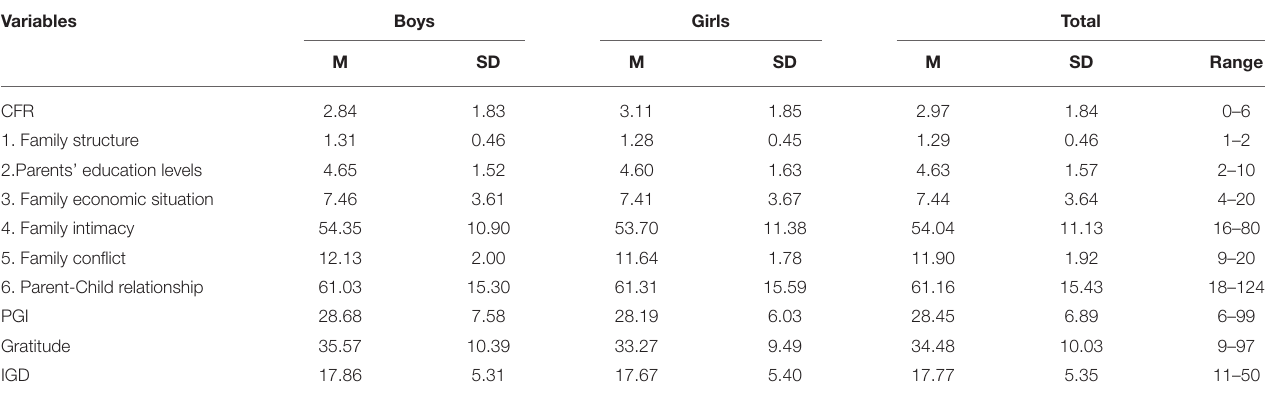
TABLE 1 | Descriptive statistics of key variables. Variables